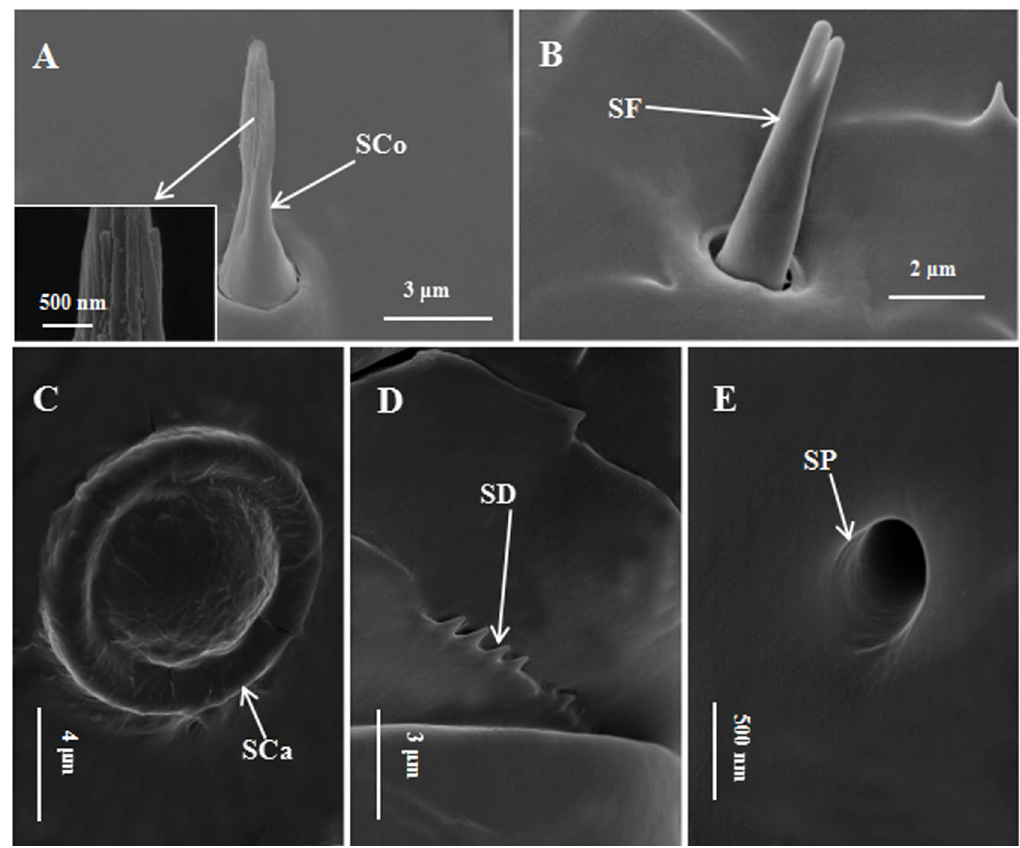
Fig 5. Scanning electron micrographs of external cuticular structures on Euplatypus parallelu antennae. A: SCo. Inset: The high magnification picture of SCo. B: SF. C: SCa. D: SD. E: SP.